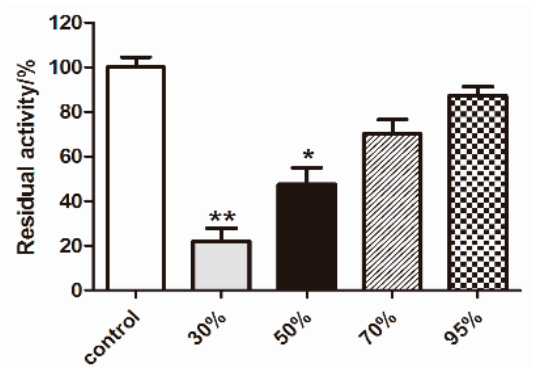
Figure 1. Inhibitory activity of different fractions of macroporous resin on FAS (fatty acid synthase). Different fractions were measured for enzyme activity at the same concentration (5 mg/mL). Values are mean ± SD ( n = 3), ** p < 0.01, * p < 0.05 vs. control.